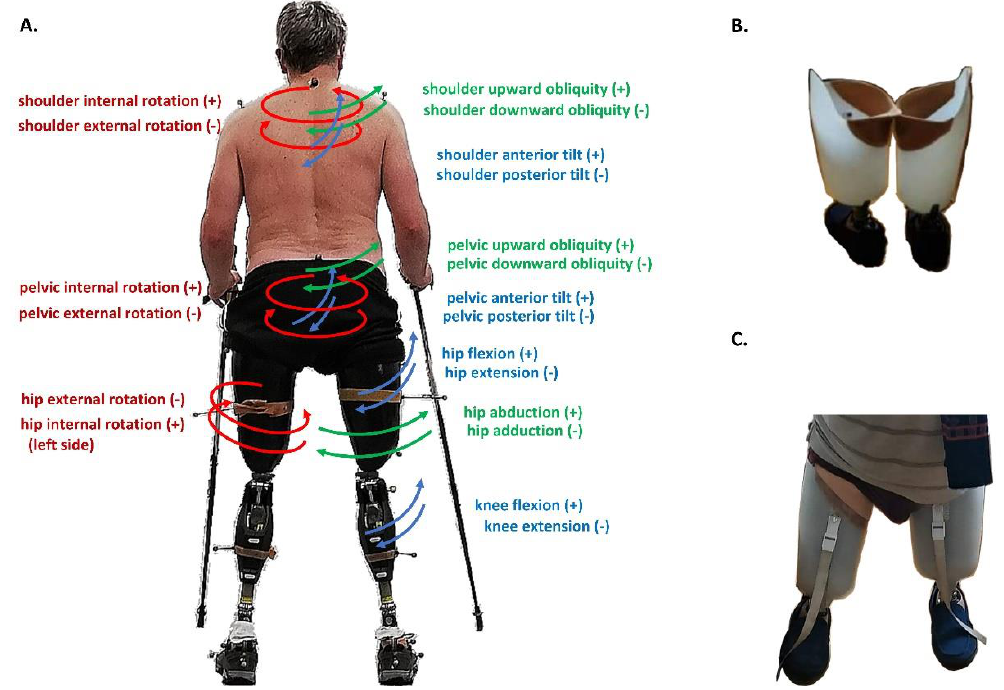
Figure 1. The main actions at shoulder, pelvis, hip and knee in sagittal (blue), frontal (green) and transversal (red) planes with arrows to explain the directions of motion ( A ). The stubby prosthesis used in the study is presented from back ( B ) and front ( C ).